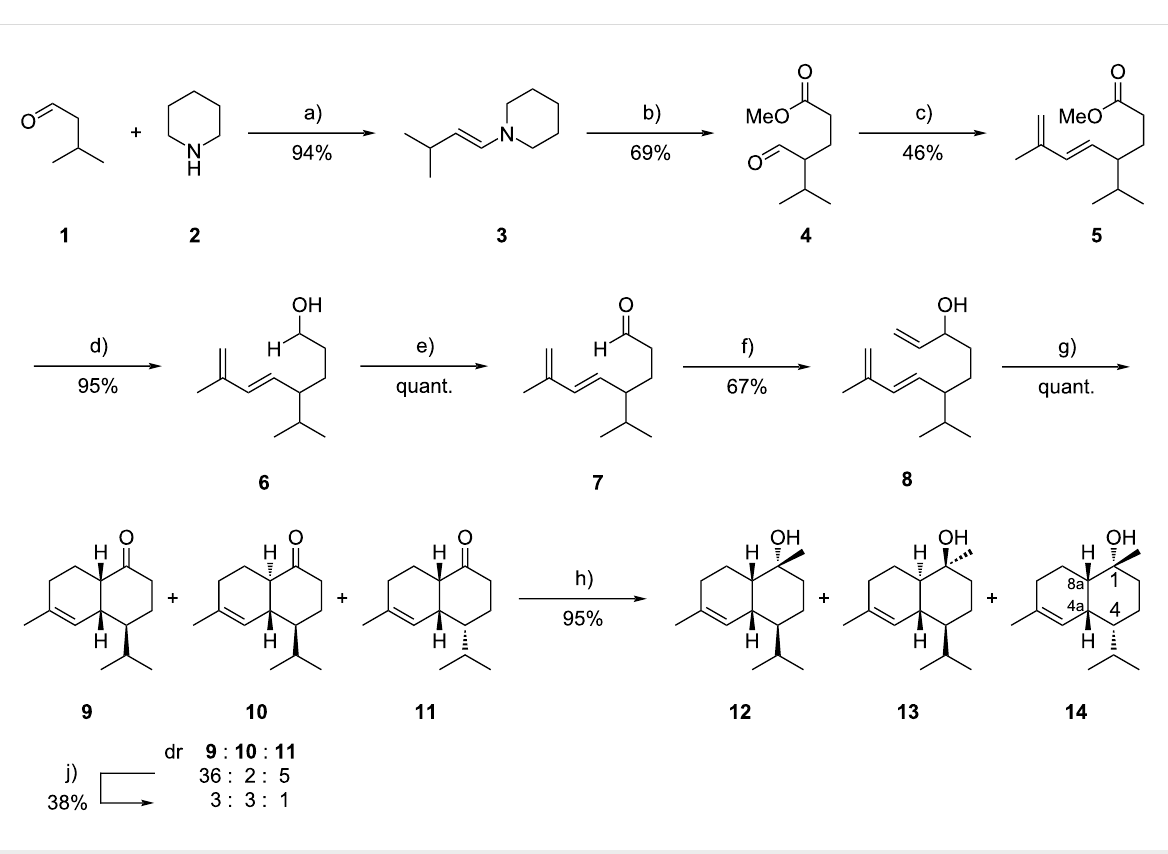
Scheme 1: Racemic synthesis of cadinols modified from Taber and Gunn [13]. Conditions a) i) K 2 CO 3 (0.35 equiv), 0 °C, 1 h, ii) rt, 2.5 h; b) i) methyl acrylate (1.3 equiv), MeCN, 90 °C, 42.5 h, ii) dest. H 2 O, AcOH, reflux, 1 h; c) i) diethyl (2-methylallyl)phosphonate (1.3 equiv), n -BuLi (1.3 equiv), THF, − 78 °C, 35 min, ii) 4 (1.0 equiv), THF, − 78 °C, 1 h, iii) rt, 1.5 h; d) i) LiAlH 4 (1.2 equiv), Et 2 O, 0 °C, 15 min ii) rt, 45 min; e) IBX (3.0 equiv), EtOAc, reflux, 3 h; f) i) CH 2 =CHMgBr (1.5 equiv) Et 2 O, 0 °C, ii) rt, 20 min; g) IBX (3.0 equiv), EtOAc, reflux, 6 h; h) i) MeMgBr (1.5 equiv) Et 2 O, 0 °C, ii) rt, 30 min; j) NaOMe (25.0 equiv), MeOH, rt, 60